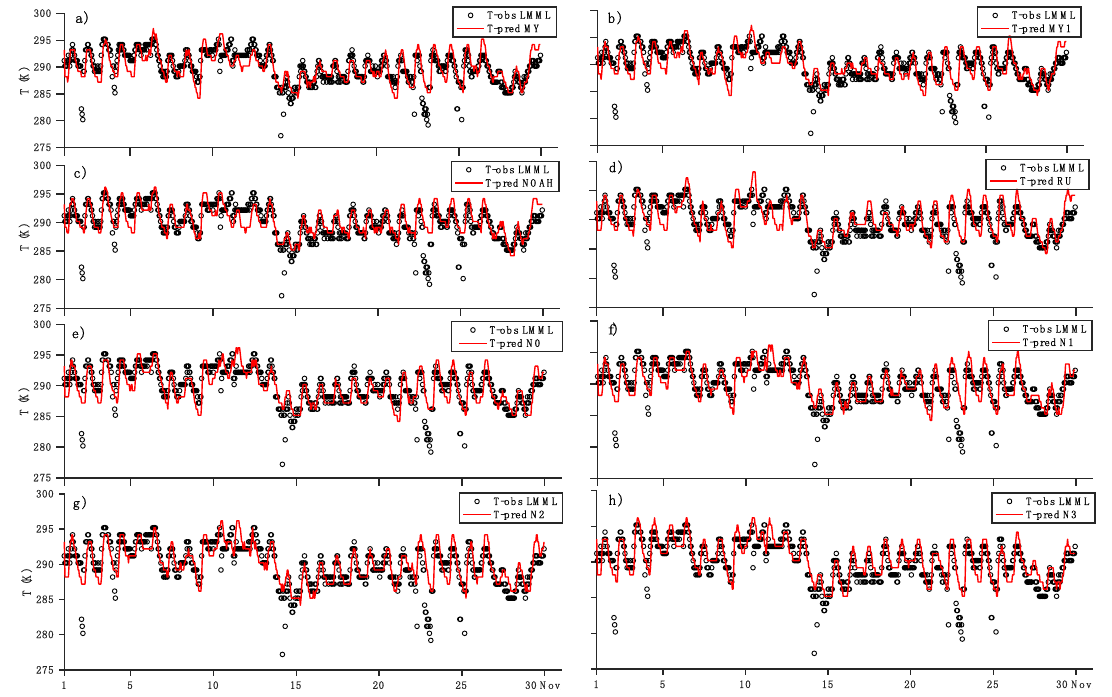
Figure 8. Time series of temperature (T) observed at LMML meteorological station versus T predicted by MY ( a ), MY1 ( b ), NOAH ( c ), RU ( d ), N0 ( e ), N1 ( f ), N2 ( g ), and N3 ( h ) simulations.